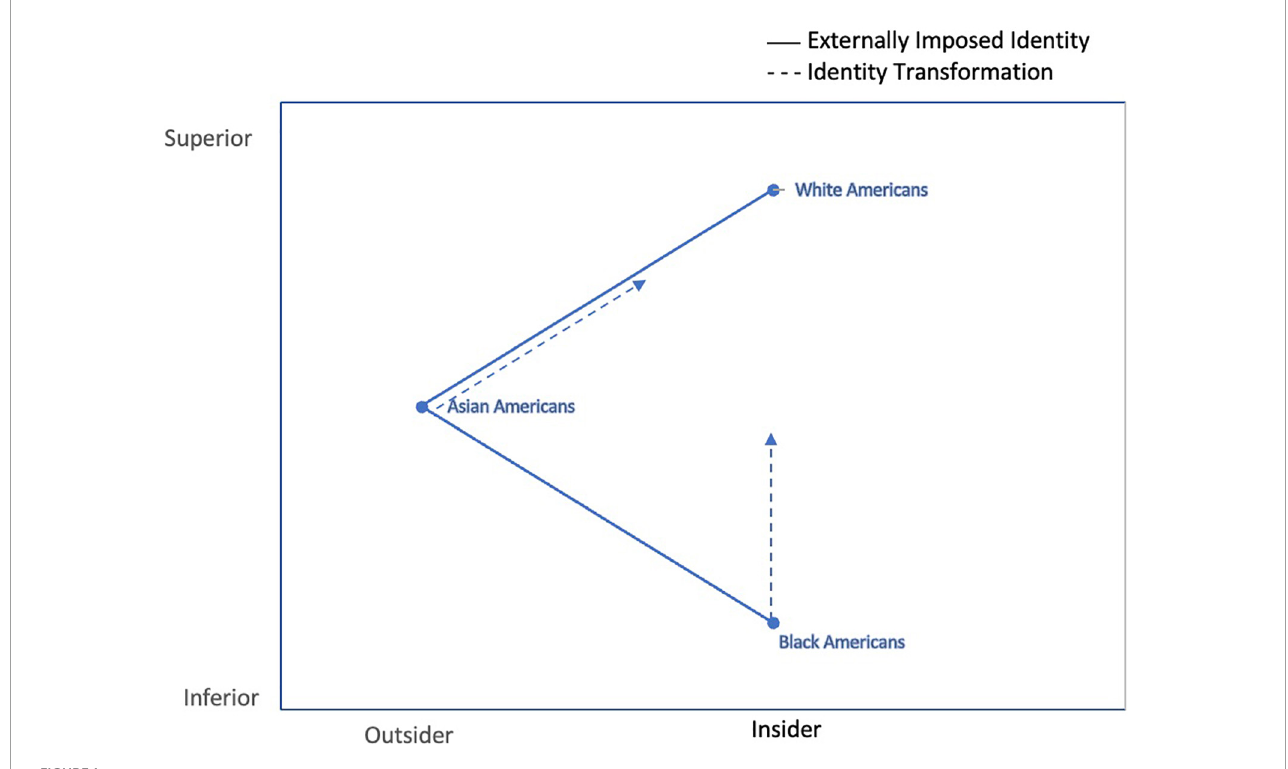
FIGURE1 Adapted from Kim (1999) Racial Triangulation Theory.